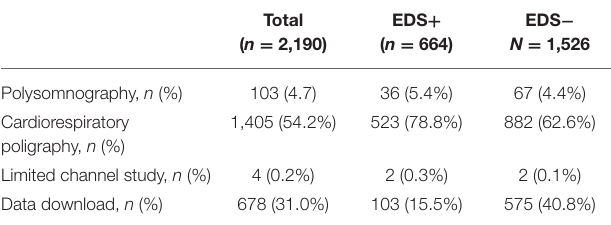
TABLE 1 | Source of sleep monitoring data at the first follow-up visit in patients without and with residual excessive subjective sleepiness (EDS). Total ( n = 2,190)